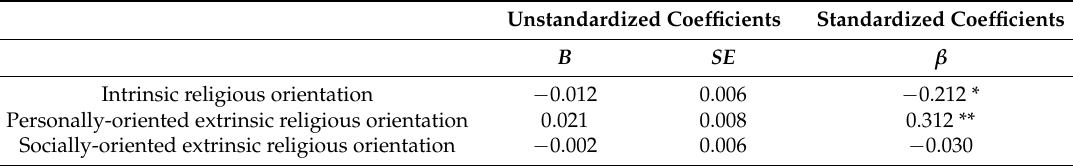
Table 4. Religious orientation: regression coefficients predicting